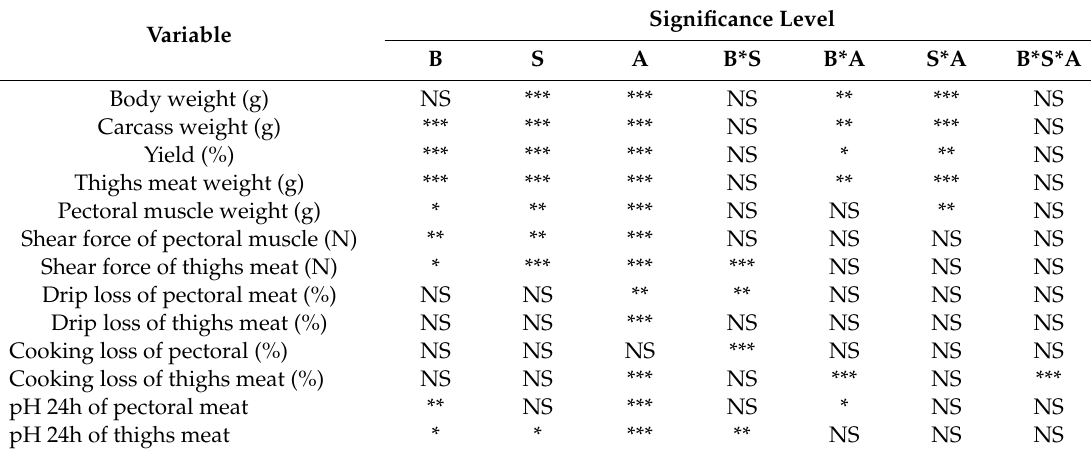
Table 4. E ff ect of Breed (B), Sex (S) and Age (A) on carcass and meat quality traits (balanced Table 4. Effect of Breed (B), Sex (S) and Age (A) on carcass and meat quality traits